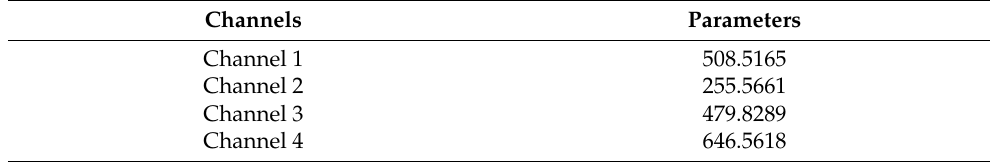
Table 13 is the result of the Throughput of the MCCH algorithm. Table 13. Throughput parameters